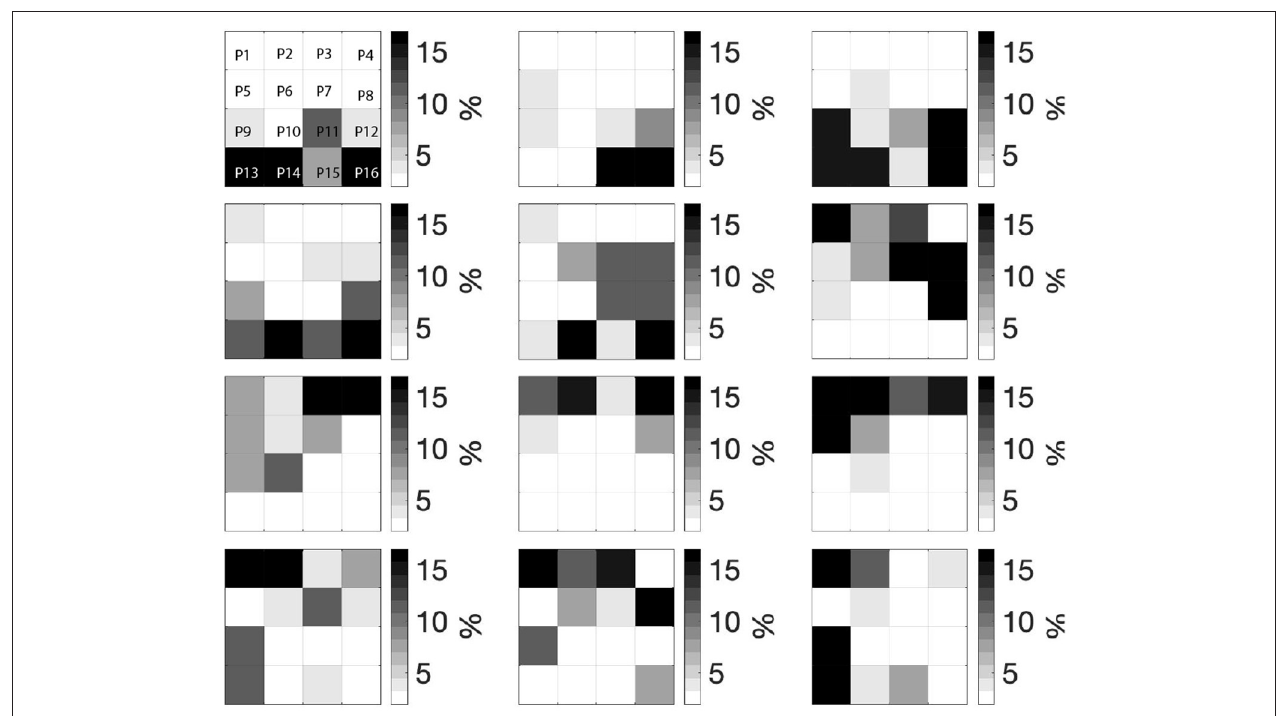
FIGURE 12 | Monthly BMUs distribution of SOM patterns shown in Figure 11 derived from 100 m depth ocean